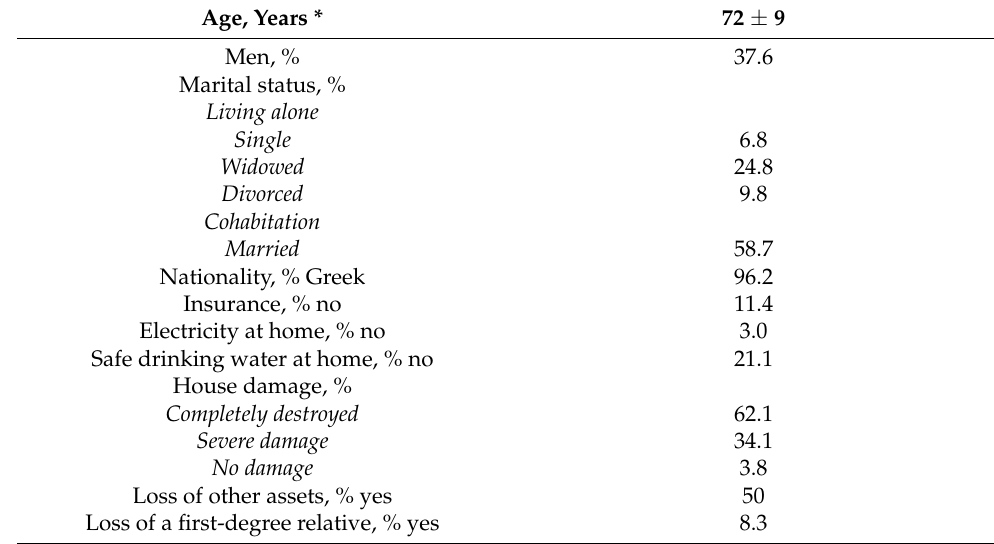
Table 1. Baseline sociodemographic characteristics ( n =